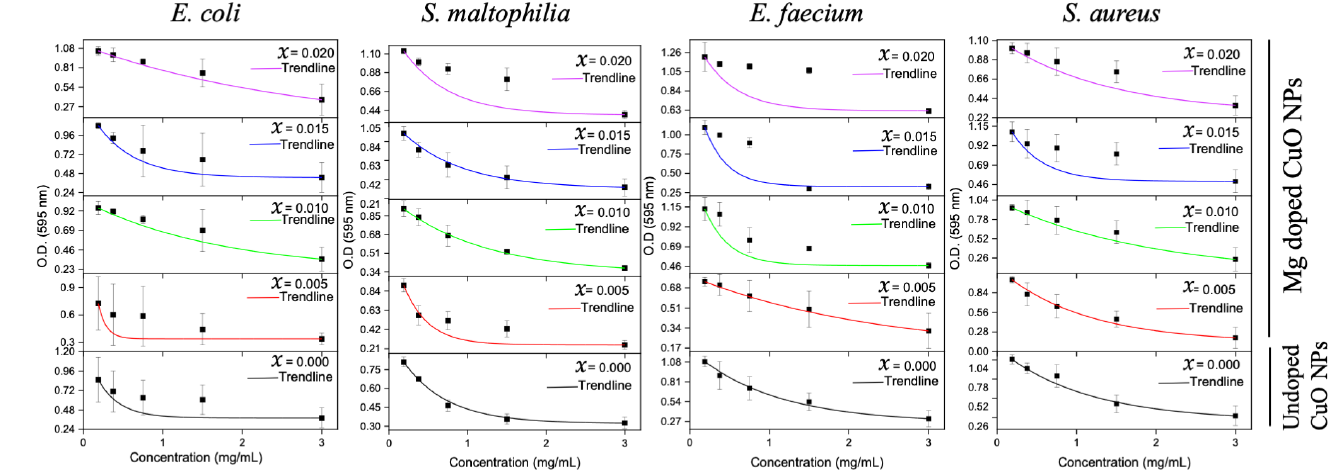
Figure A1. MICs of the undoped and Mg-doped NPs against four bacterial isolates.